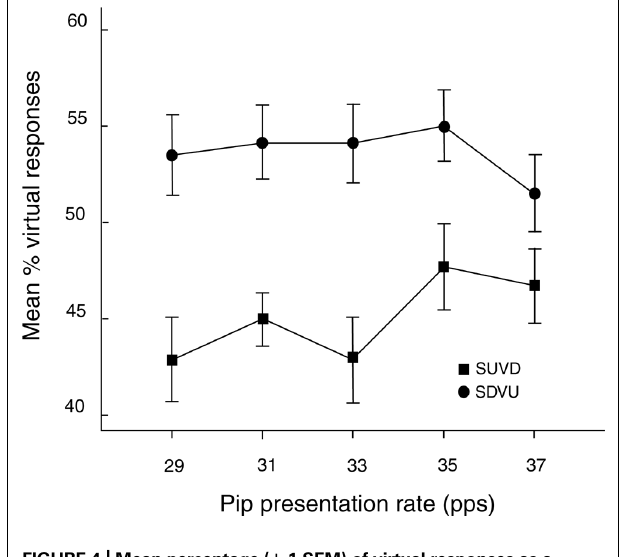
FIGURE 4 | Mean percentage ( ± 1 SEM) of virtual responses as a function of rate and target. SDVU = spectral down – virtual up; SUVD = spectral up – virtual